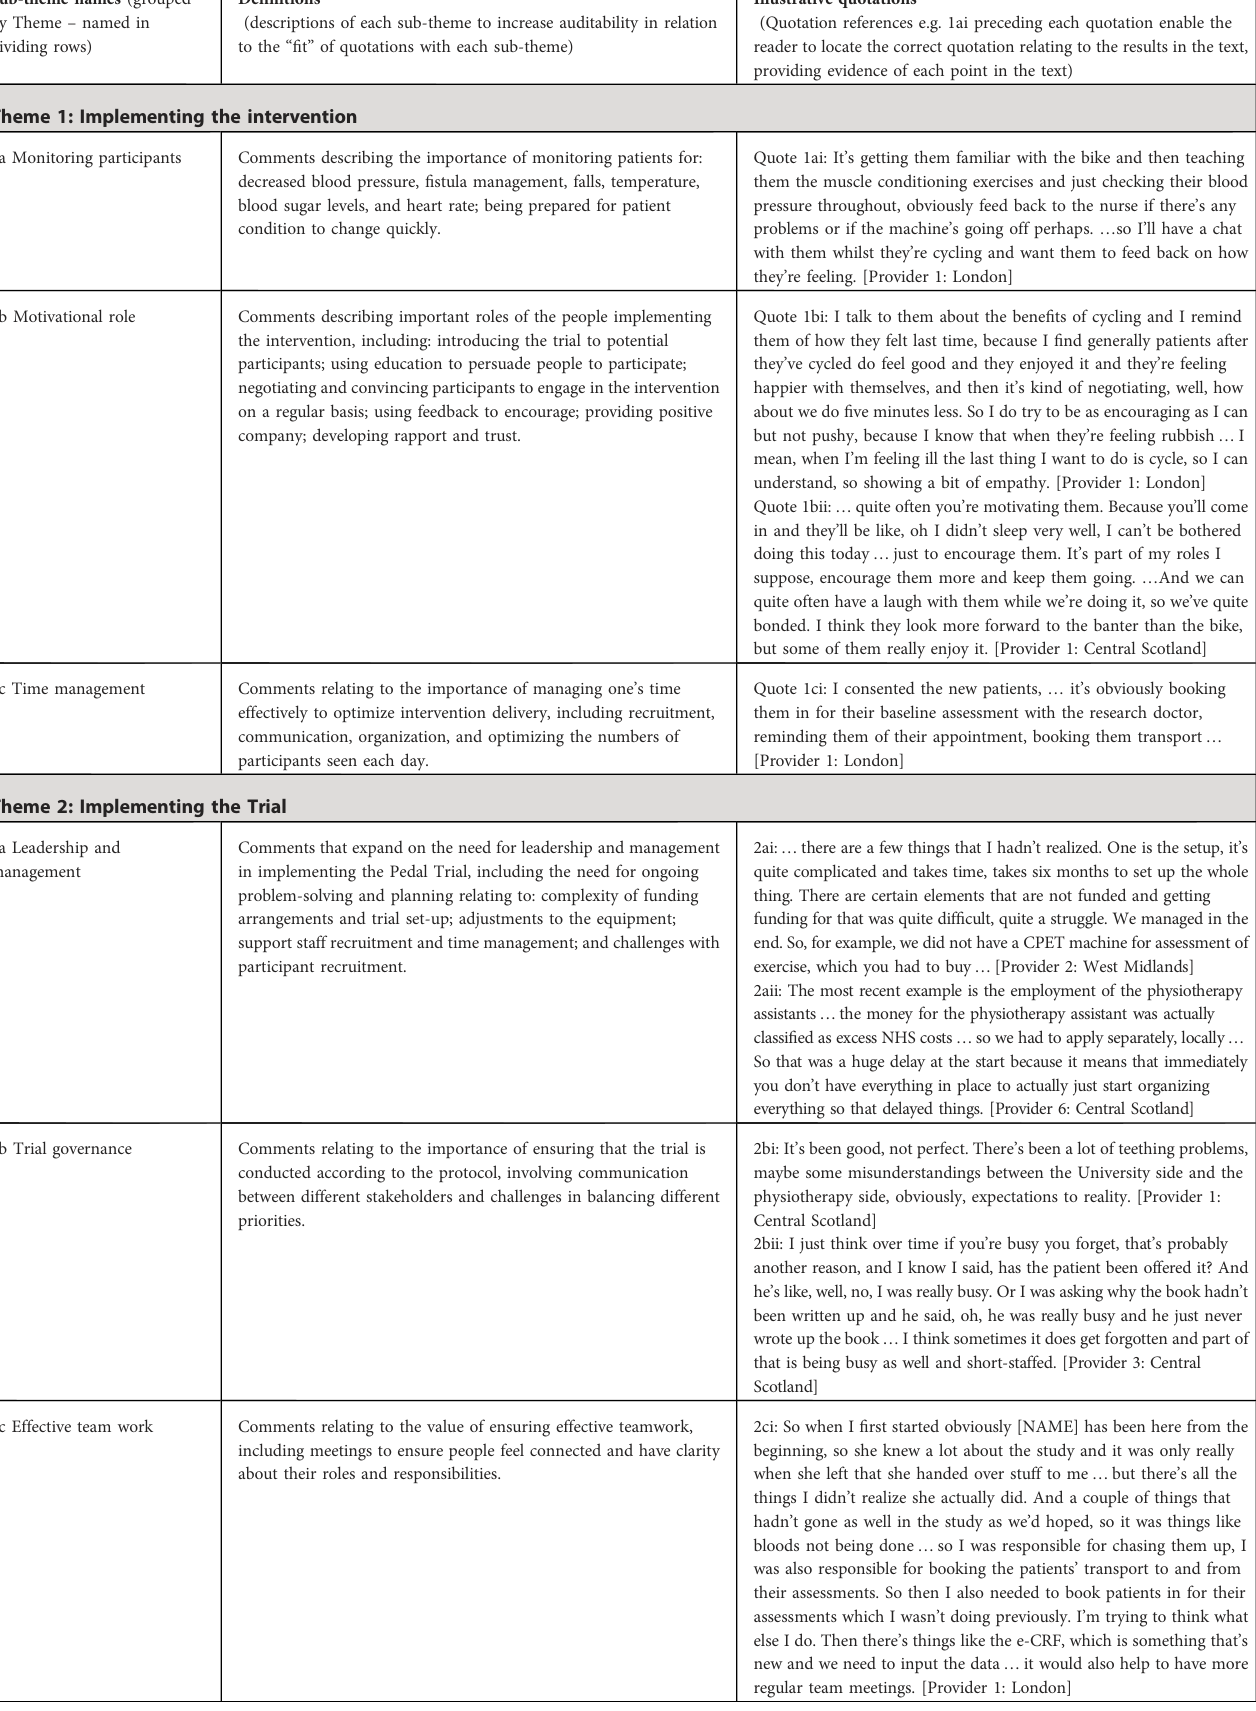
TABLE 1 Summary of overarching themes and de fi nitions with example data. Sub-theme names (grouped by Theme – named in dividing